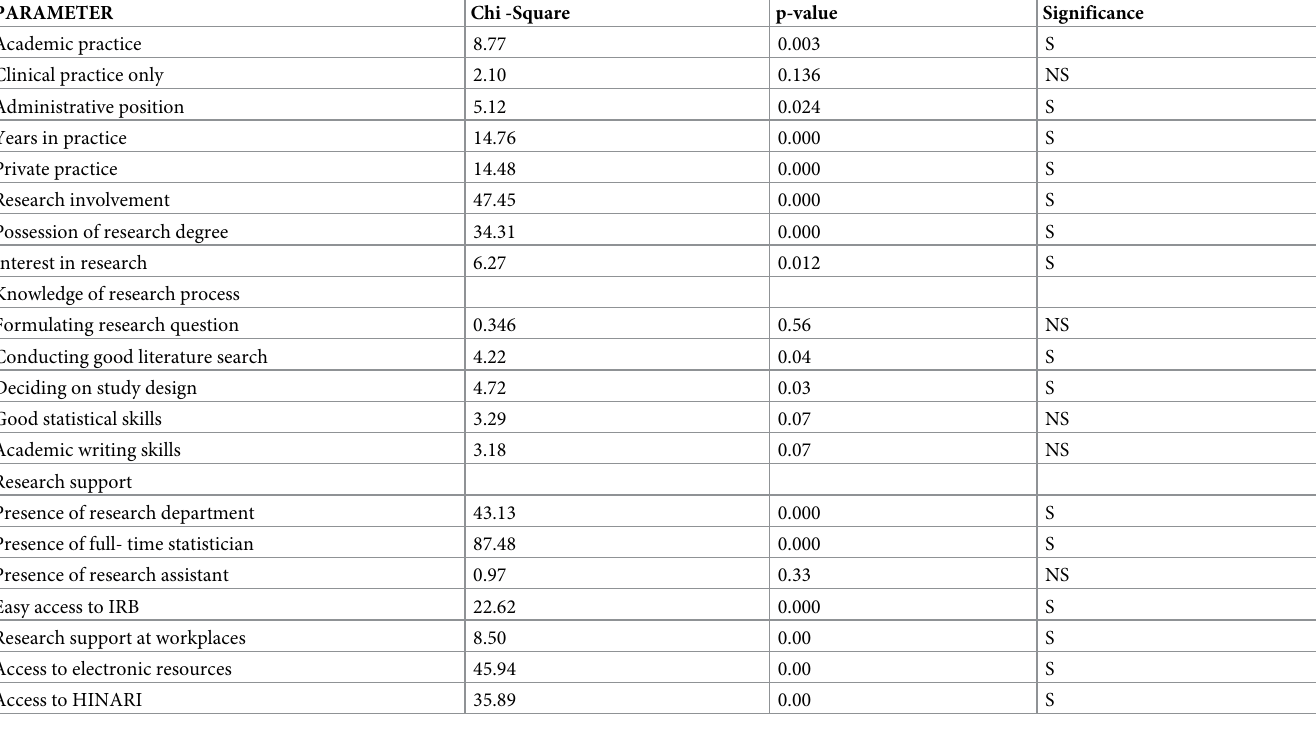
Table 6. Factors associated with research